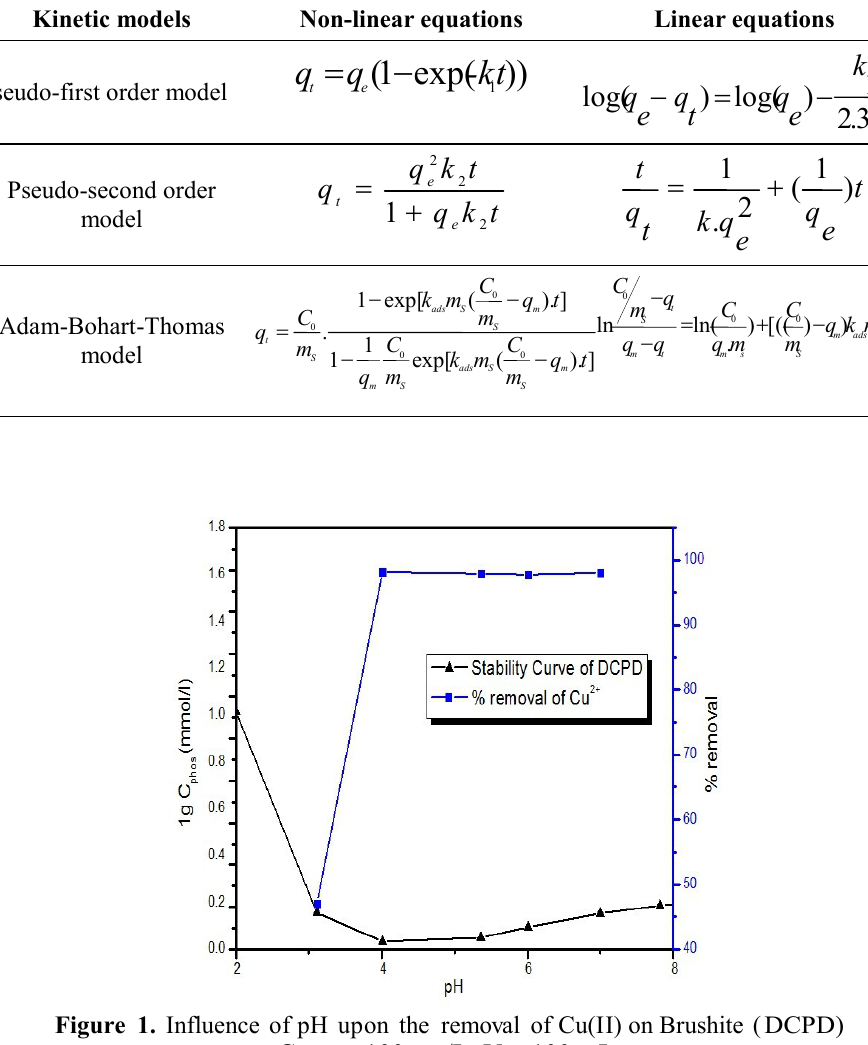
Table 1. Non-linear and linear equations of different kinetic models.